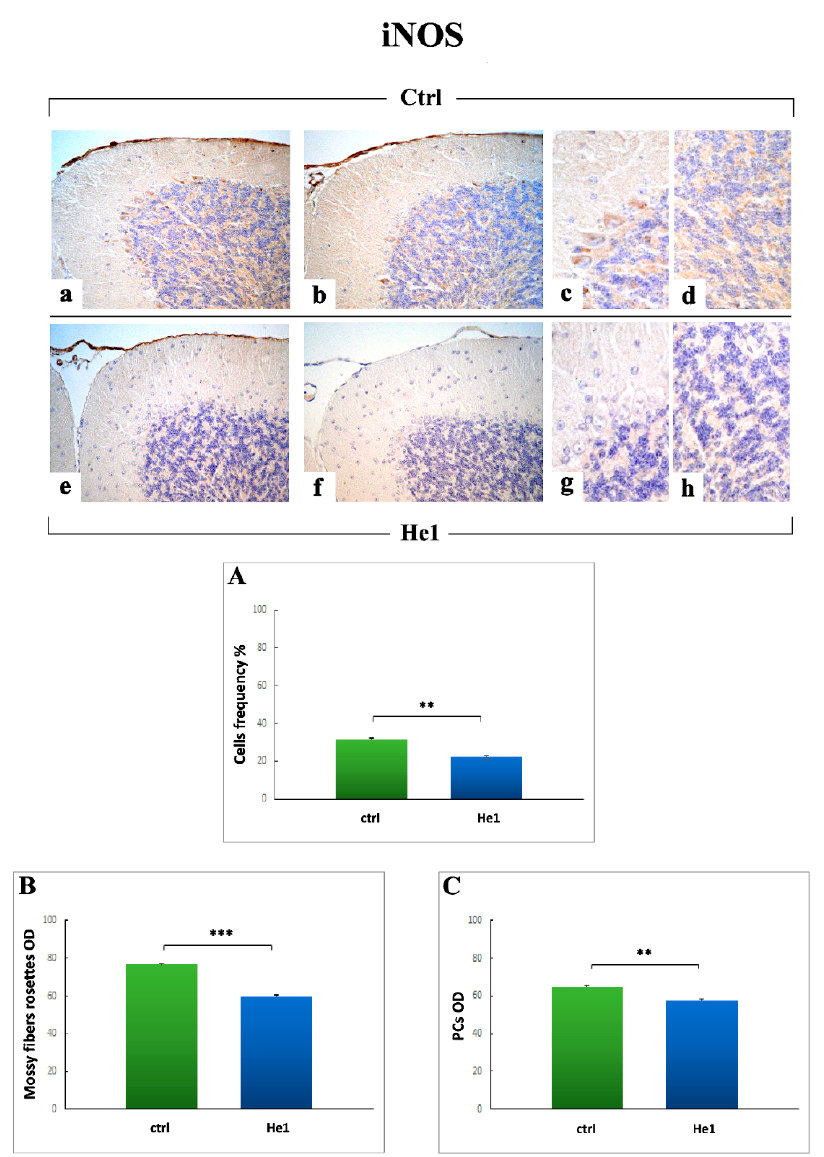
Figure 12. Immunohistochemical labeling for NOS2 in untreated animals ( a – d ) and He1 mice ( e – h ). Objective magnification: 40× ( a , b , e , f ); 100× ( c , d , g , h ). Panels ( A – C ) Histograms presenting the quantitative measurement of NOS2 immunopositive cell frequency, and OD evaluation for both mossy fibers rosettes as well as Purkinje neurons. p values calculated by unpaired Student’s t -test: ** p < 0.01, *** p < 0.001.